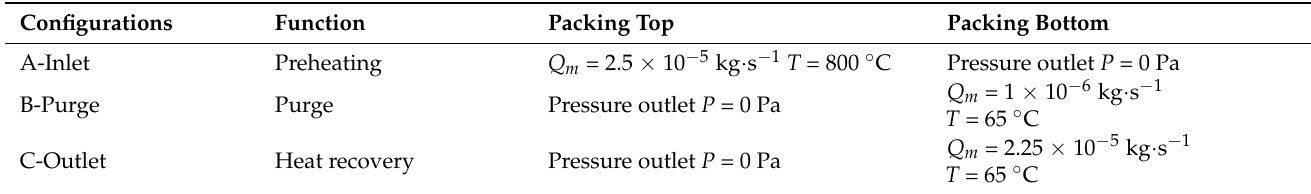
Table 5. Boundary conditions of flow channel inlet and outlet.